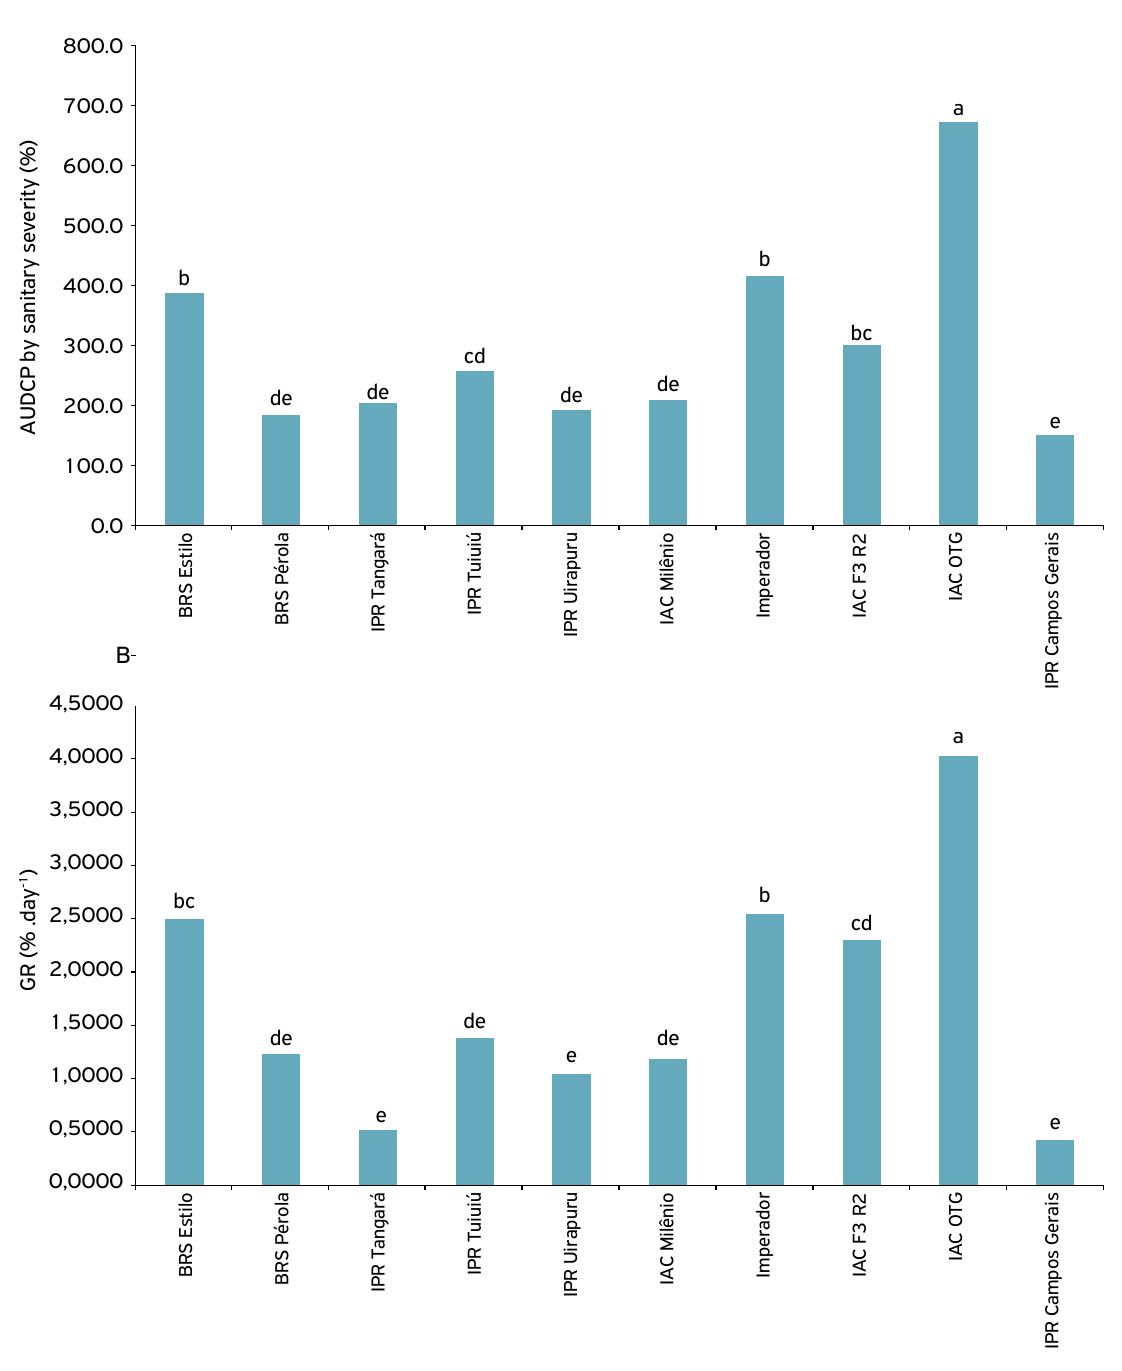
Figure 1. Epidemiological parameters obtained from sanitary severity in different commercial common bean cultivars. (A) AUDCP - Area below the disease progress curve, (B) GR -Growth rate (%.day -1 ); averages followed by the same vertical letters do not differ from each other to the Tukey test at p ~